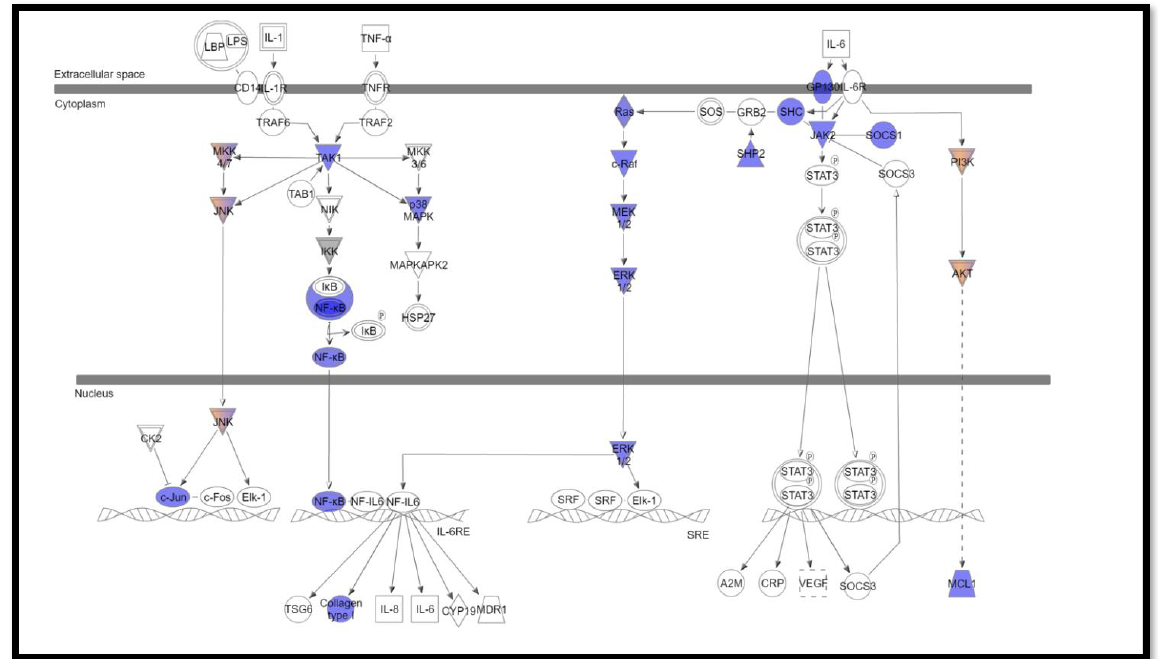
Figure 2. IL-6 signaling pathway identified using ingenuity variant analysis (IVA). Blue represents loss of function, and orange represents gain of function.